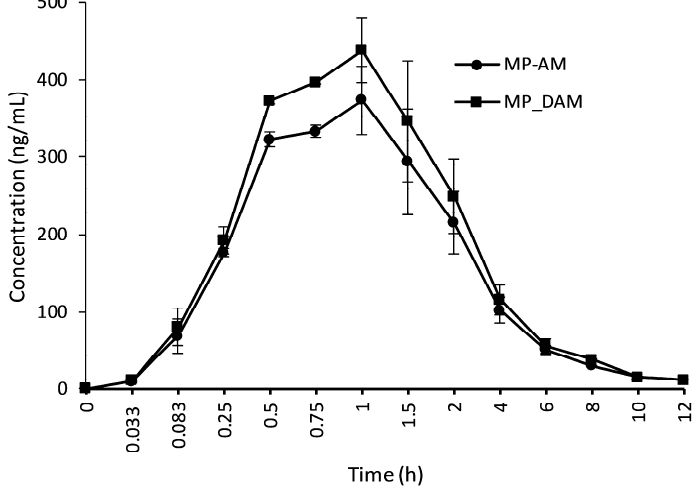
Figure 3. Plasma concentration-time curves of the Active Metabolites produced after simultaneous oral administration of vicagrel and 10a to male Wistar rats at a dose of 72 μ mol/kg. Each data point is expressed as mean ± SD ( n = 3).